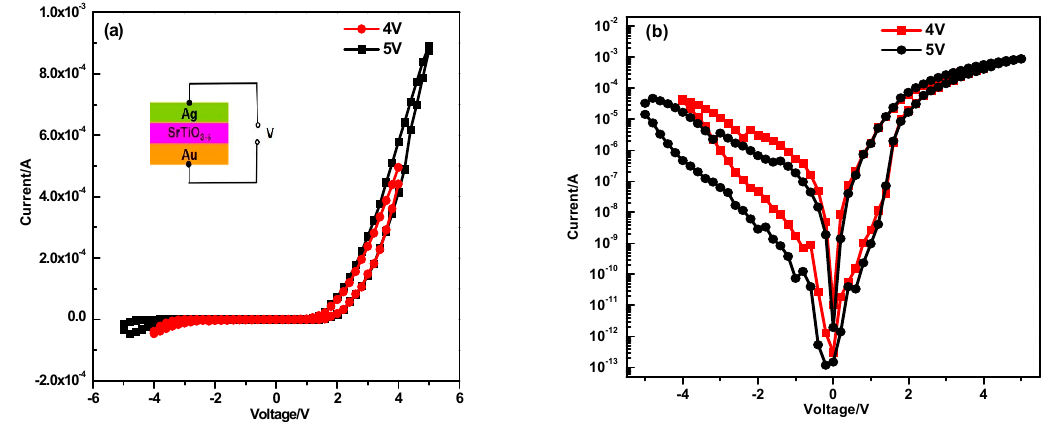
Figure 5. ( a ) The I-V characteristic and ( b ) semi-log I-V curve of the “24 h” sample in the configuration of Au/SrTiO 3 /Ag.